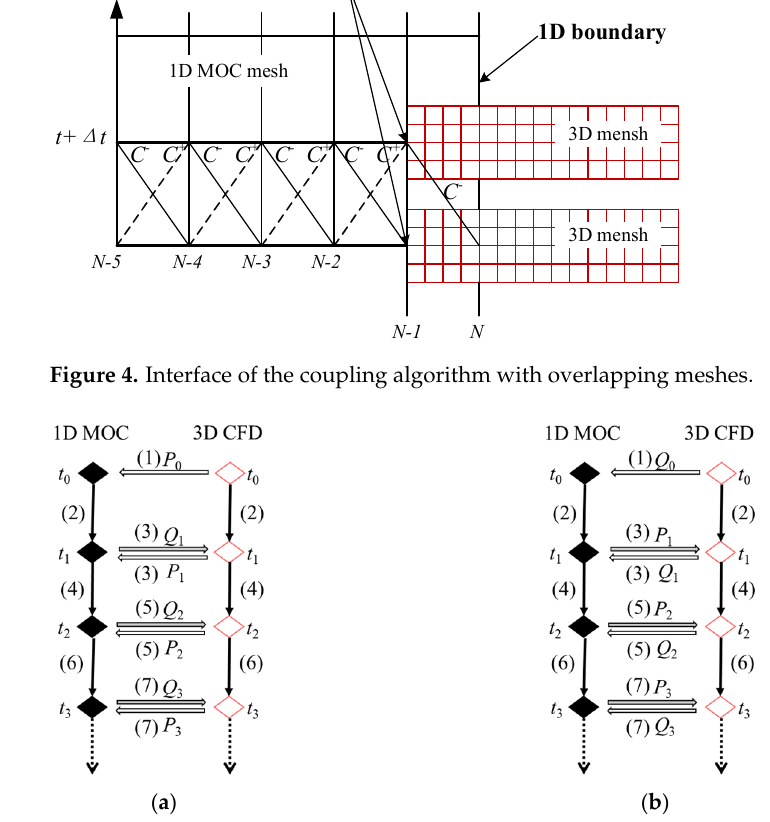
Figure 4. Interface of the coupling algorithm with overlapping meshes.